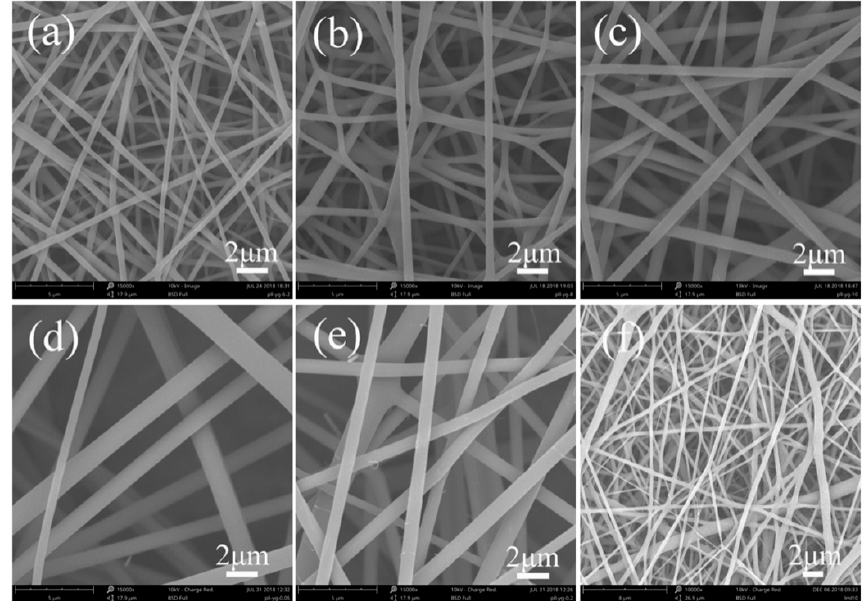
Figure 1. SEM images of fluorescent SF-FS nanofibers with different SF and FS concentrations. The concentration of SF was ( a ) 6.0 wt%, ( b ) 8.0 wt%, and ( c – e ) 10.0 wt%. The concentration of FS was ( a – c ) 1.0 wt%, ( d ) 0.5 wt%, and ( e ) 2.0 wt%, respectively. ( f ) Pure SF nanofibers with 6.0 wt% SF